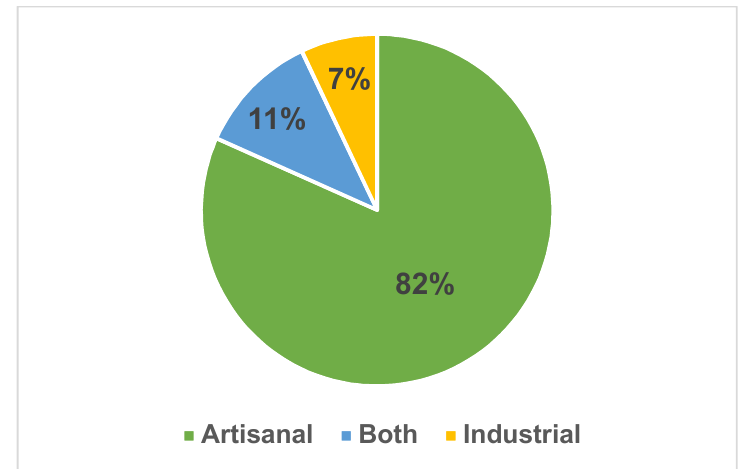
Figure 10 . Percentage of flat breads produced in artisanal or industrial mode. Figure 10. Percentage of flat breads produced in artisanal or industrial